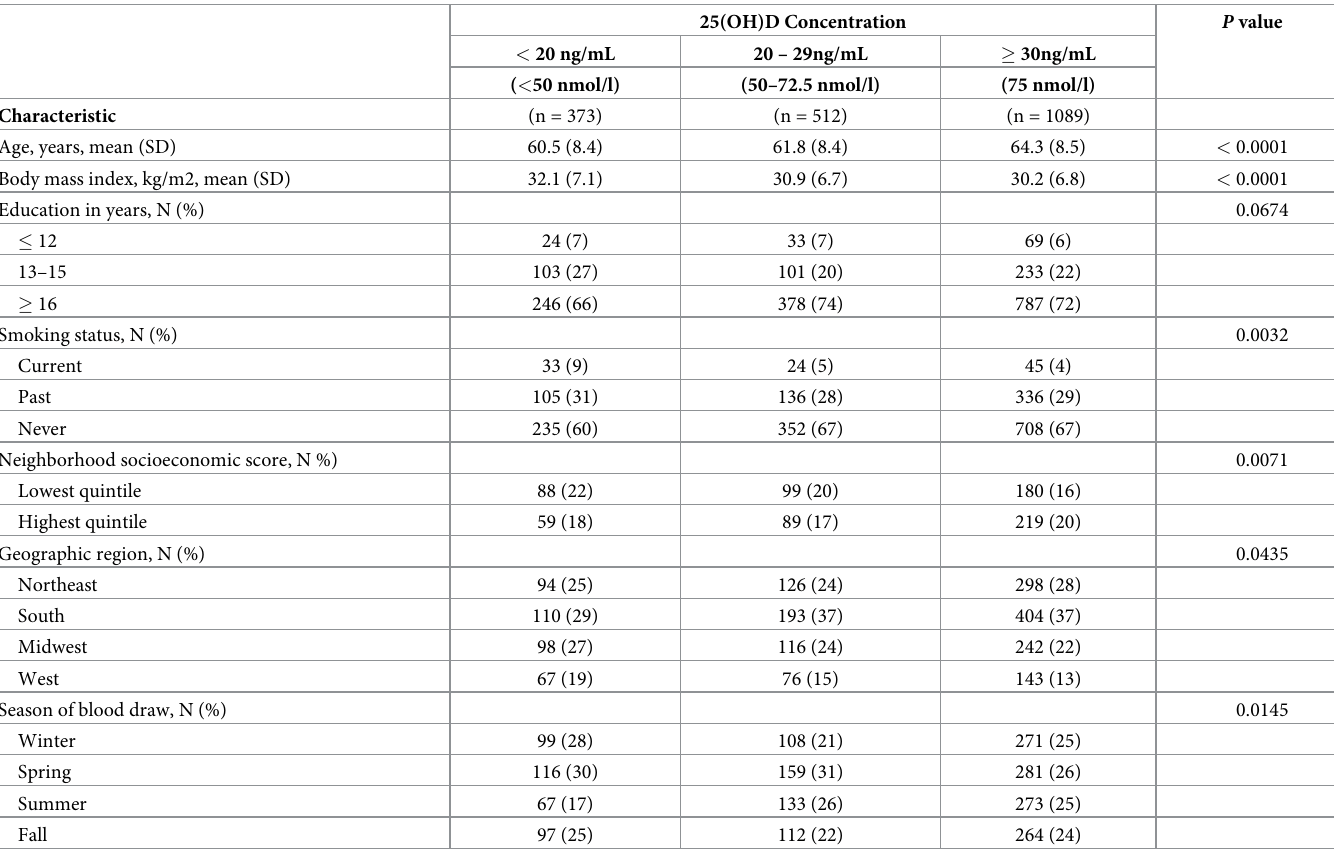
Table 1. Participant characteristics in relation to levels of serum 25(OH)D at the time of blood draw, Black Women’s Health Study.